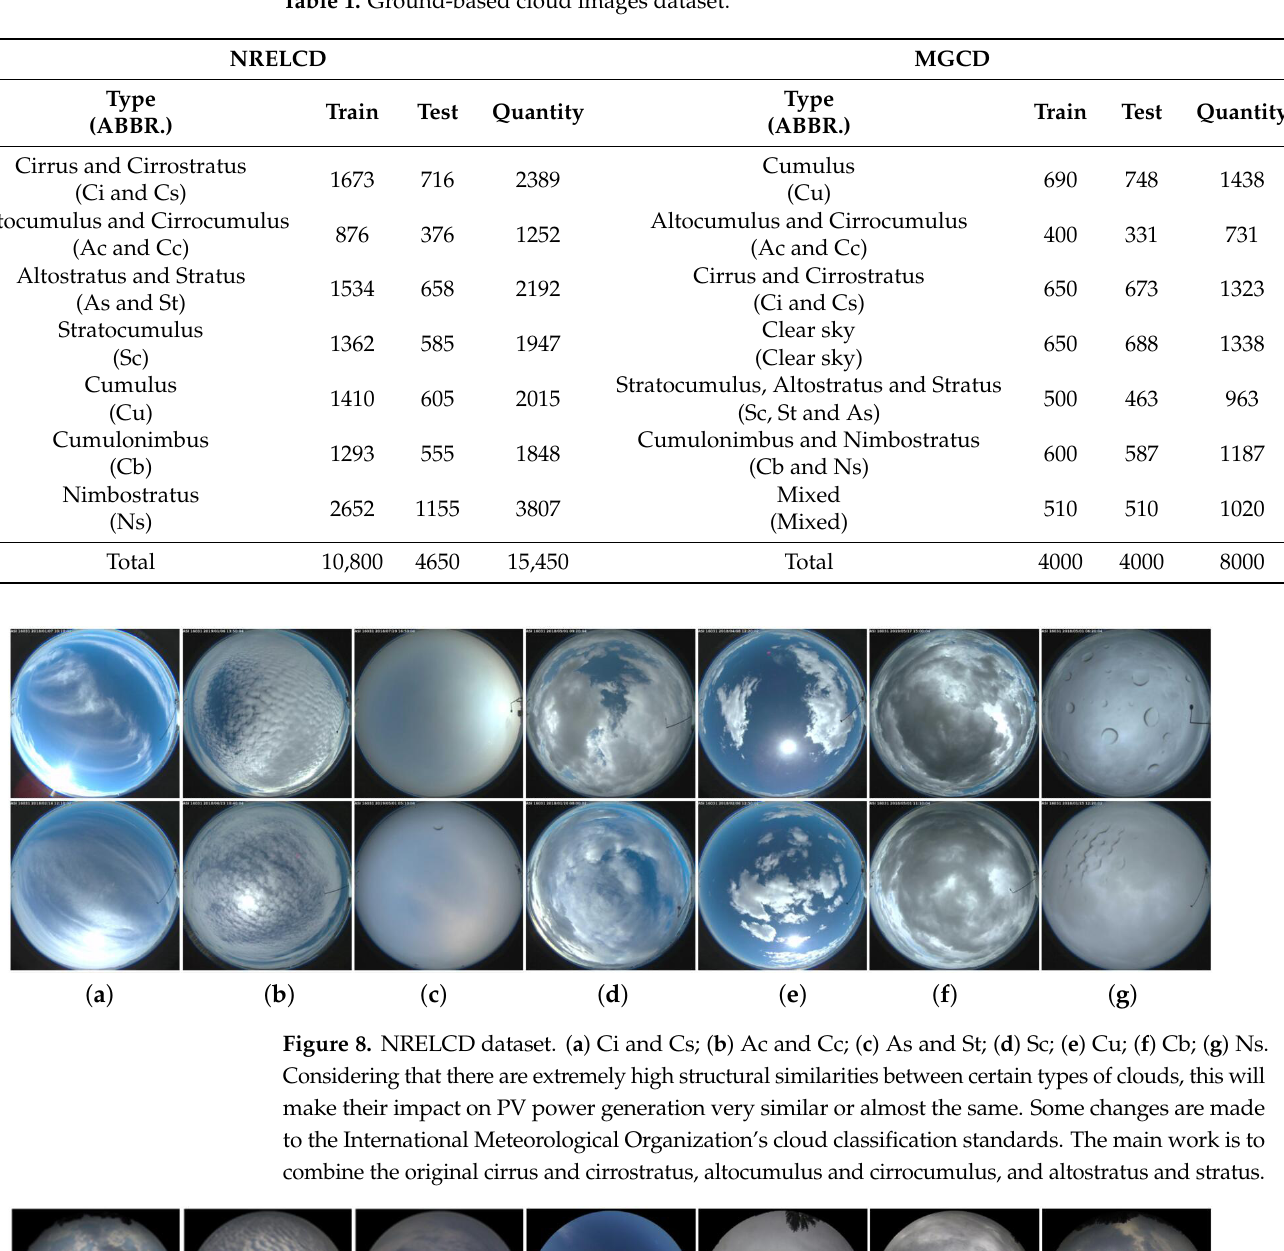
Table 1. Ground-based cloud images dataset.